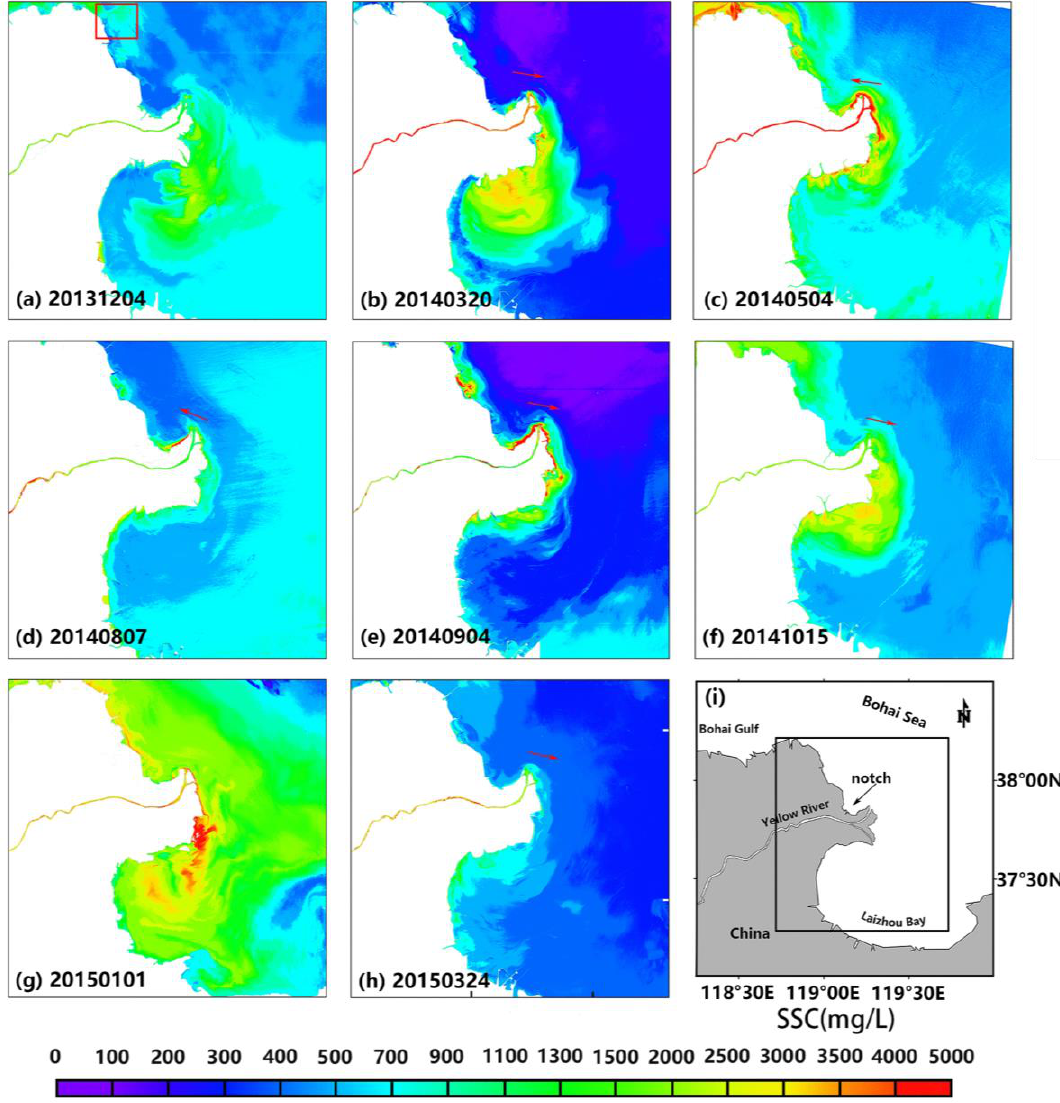
Figure 4. Retrieved from GF-1 WFV1 image. The red arrow in the figure present the local current direction. The red box in ( a ) is the location of Dongying Dam (Dongying port). The black box in ( i ) is the area of the retrieved images in the study area.